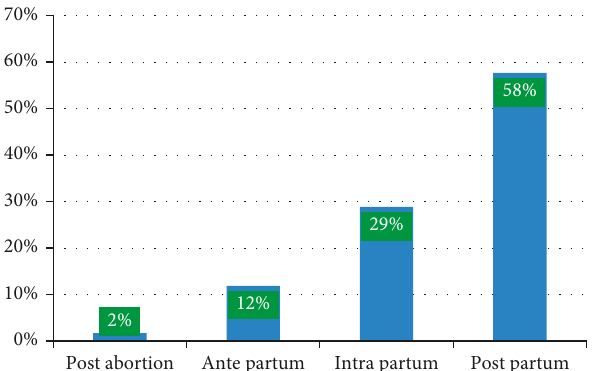
Figure 2: State of pregnancy at time of death, at pastoralist area of Borena zone, Oromia region, Ethiopia, 2017.